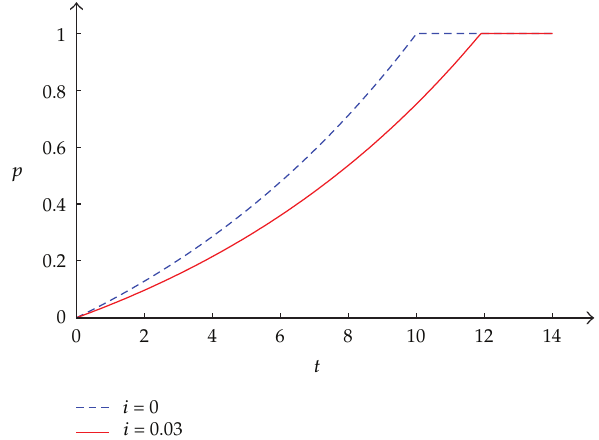
Figure 1: The e ff ect of the interest rate i on the randomized strategy p